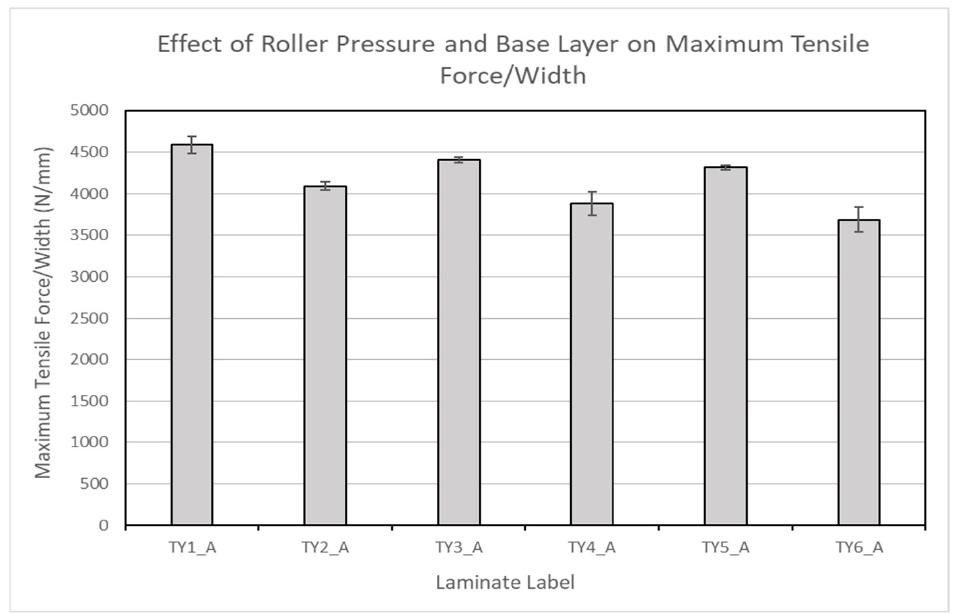
Figure 12. Effect of roller pressure and base layer on maximum tensile force/width for all laminates. The effect of roller pressure and base layer on ultimate tensile strength for layups without a prepreg base layer is shown in Figure 13. The ultimate tensile strength increases from 1802.76 MPa at 2 bar roller pressure to 1983.38 MPa at 3.5 bar roller pressure before decreasing to 1864.01 MPa as the pressure is increased further to 5 bar. The change is sim- ilar to that observed for the maximum tensile force per width. Figure 13. Effect of roller pressure and base layer on ultimate tensile strength for layups without prepreg base layer. Figure 14 shows the effect of roller pressure and base layer on ultimate tensile strength for layups on a prepreg base layer. The ultimate tensile strength at roller pressure of 3.5 bar is 5.5% and 3.5% higher than those at 2 bar and 5 bar roller pressures. The addi- tion of the prepreg base layer improves the ultimate tensile strength at all the tested roller pressures.